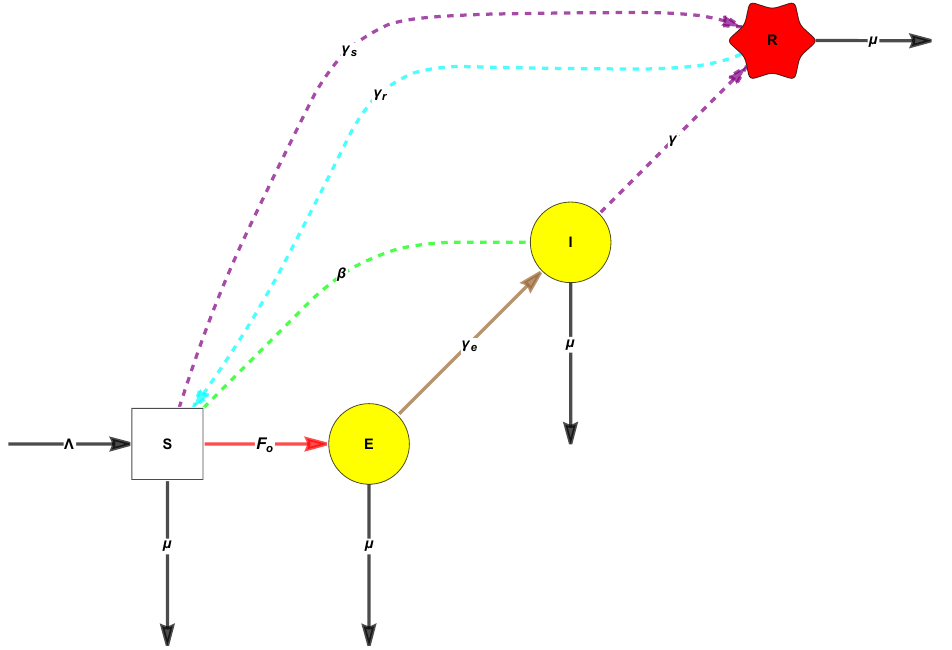
Figure 1. Chart flow of the SEIRS model. The force of infection is F o = β i . The red edge corresponds to the entrance of susceptibilities into the disease classes, the dashed green edges correspond to the contacts between the diseases and susceptibilities, the brown edge is the rate of the transition matrix V , and the cyan dashed line corresponds to the rate of waning immunity. The remaining black lines correspond to the inputs and outputs of the birth and natural death rates,